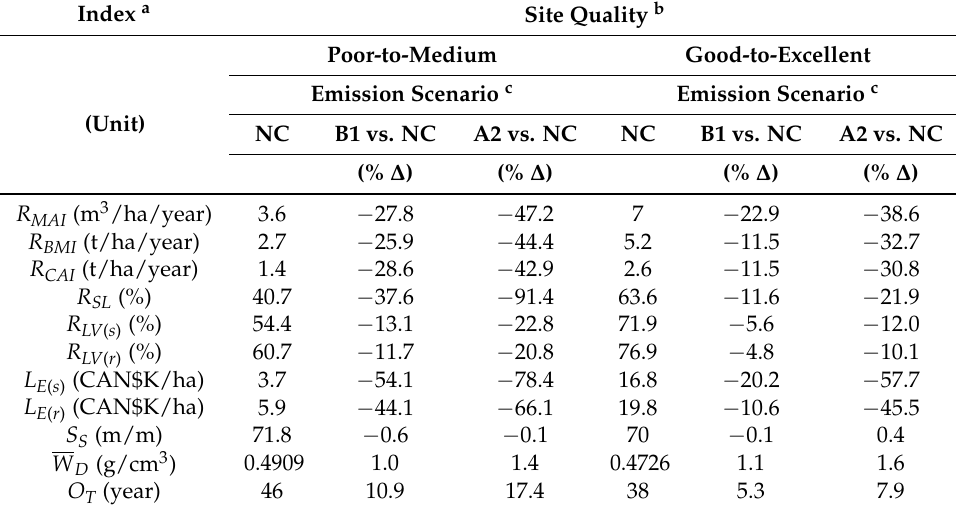
a–c : As defined in Table 3a table notes. Table 4a. Stand-level performance indices for jack pine plantations managed under a basic silvicultural intensity in north-eastern Ontario by emission scenario and site